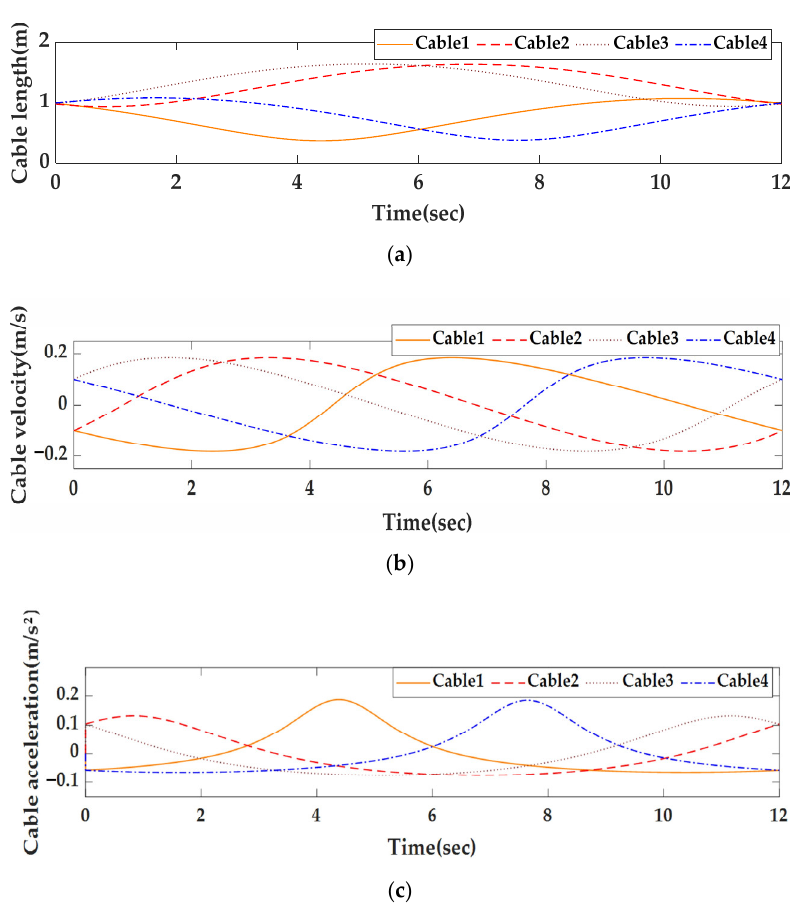
Figure 8. The kinematic simulation result: ( a ) cable length variation diagram; ( b ) cable velocity variation diagram; ( c ) cable acceleration variation diagram.